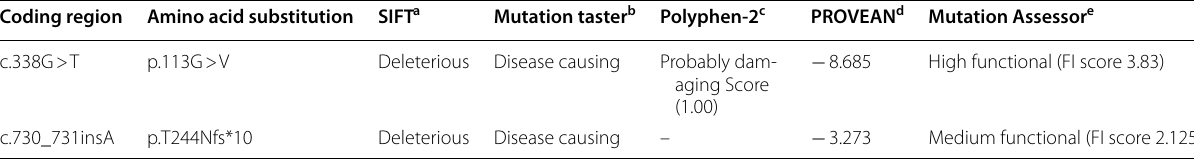
a SIFT classify substitutions as damaging (SIFTscore: < 0.05) or tolerant (SIFTscore: > 0.05) b Evaluate DNA sequence variants for their disease-causing potential c PolyPhen-2 appraises a mutation qualitatively, as benign, possibly damaging or probably damaging based on pairs of false positive rate (FPR) thresholds d PROVEAN (Protein Variation Effect Analyzer) v1.1: classify substitutions as Bdeleterious^ (PROVEAN score is equal to or below a predefined threshold the PROVEAN score is above the threshold, the variant is predicted to have a neutral effect e Mutation Assessor gives substitutions as high functional (FI score: 3.50–5.50), medium functional (FI score: 2.00–3.50), low non-functional (FI score: 1.00–2.00) or neutral non-functional (FI score: < 1.00)